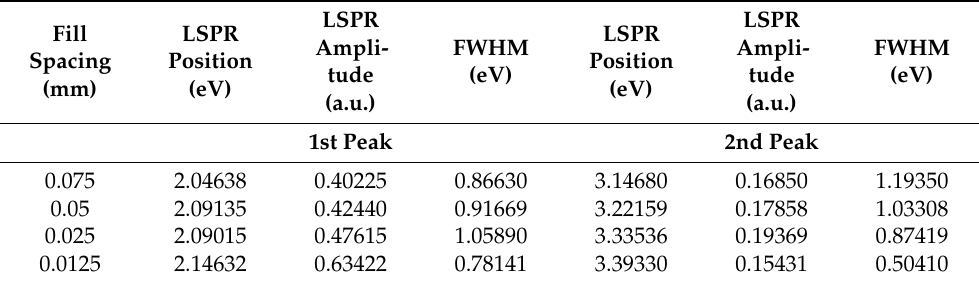
Figure 3. Graphic illustrations of the LSPR characteristics of a 13.5 nm Ag film (Ag #1), as a function of the fill spacing. The main figures show the data for the main peaks, while the insets show the data for the secondary peaks. ( a ) LSPR position; ( b ) LSPR amplitude; ( c ) FWHM. No FWHM data could be extracted for the secondary peaks. Table 2. LSPR characteristics as a function of the fill spacing. It must be noted that all measurements presented in the table were carried out at a laser frequency of 60 kHz.